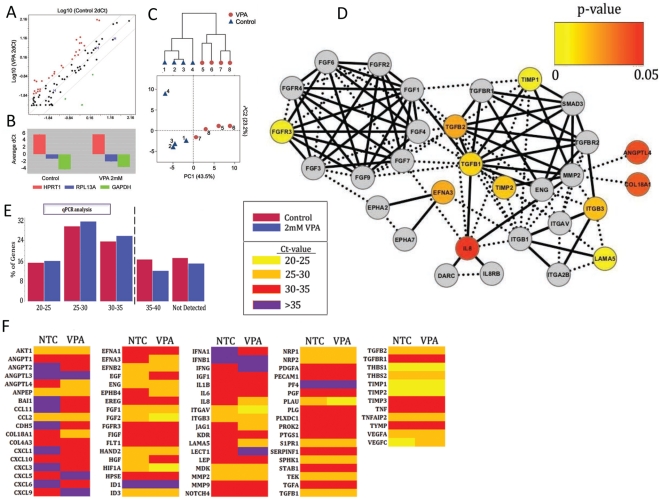
Effect of VPA on expression of angiogenesis related genes in human pericytes.Characterization of changes in angiogenesis gene expression in pericytes exposed to 2 mM VPA over three days compared to NTC using a qPCR angiogenesis microarray. (A) Scatter plot based on transformed ΔCt values for NTC and VPA for each gene. Each axis is in the log10 scale. The letter H represents the expression of housekeeping genes. (B) The average ΔCt value for the three housekeeping genes (HPRT1, RPL13A and GAPDH) used in the qPCR analysis. (C) Combination of unsupervised hierarchical clustering and principal component analysis. The dendrogram shows that NTC and VPA samples separate from each other. The first component (PC1) explains 43.5% of the variation in the data and separates NTC from VPA samples. NTC sample 4 differs somewhat from the other NTC (see PC2). (D) Network analysis of the most significant angiogenesis genes using data exported from the STRING database and visualized in Cytoscape. Edges between nodes are based on different levels of evidence. Solid lines are based on a high combined STRING confidence level (>0.9) whereas dotted lines are <0.9. The color of the nodes/genes is based on their p-value from the pair-wise comparison between NTC and VPA samples. Gray colored nodes represent genes not analyzed in this experiment and do therefore not possess any p-values. (E) Percentage of the total included 84 genes that were expressed in each Ct value range in VPA and NTC pericytes. (F) Shifts in Ct value ranges in each individual gene in VPA compared to NTC pericytes.